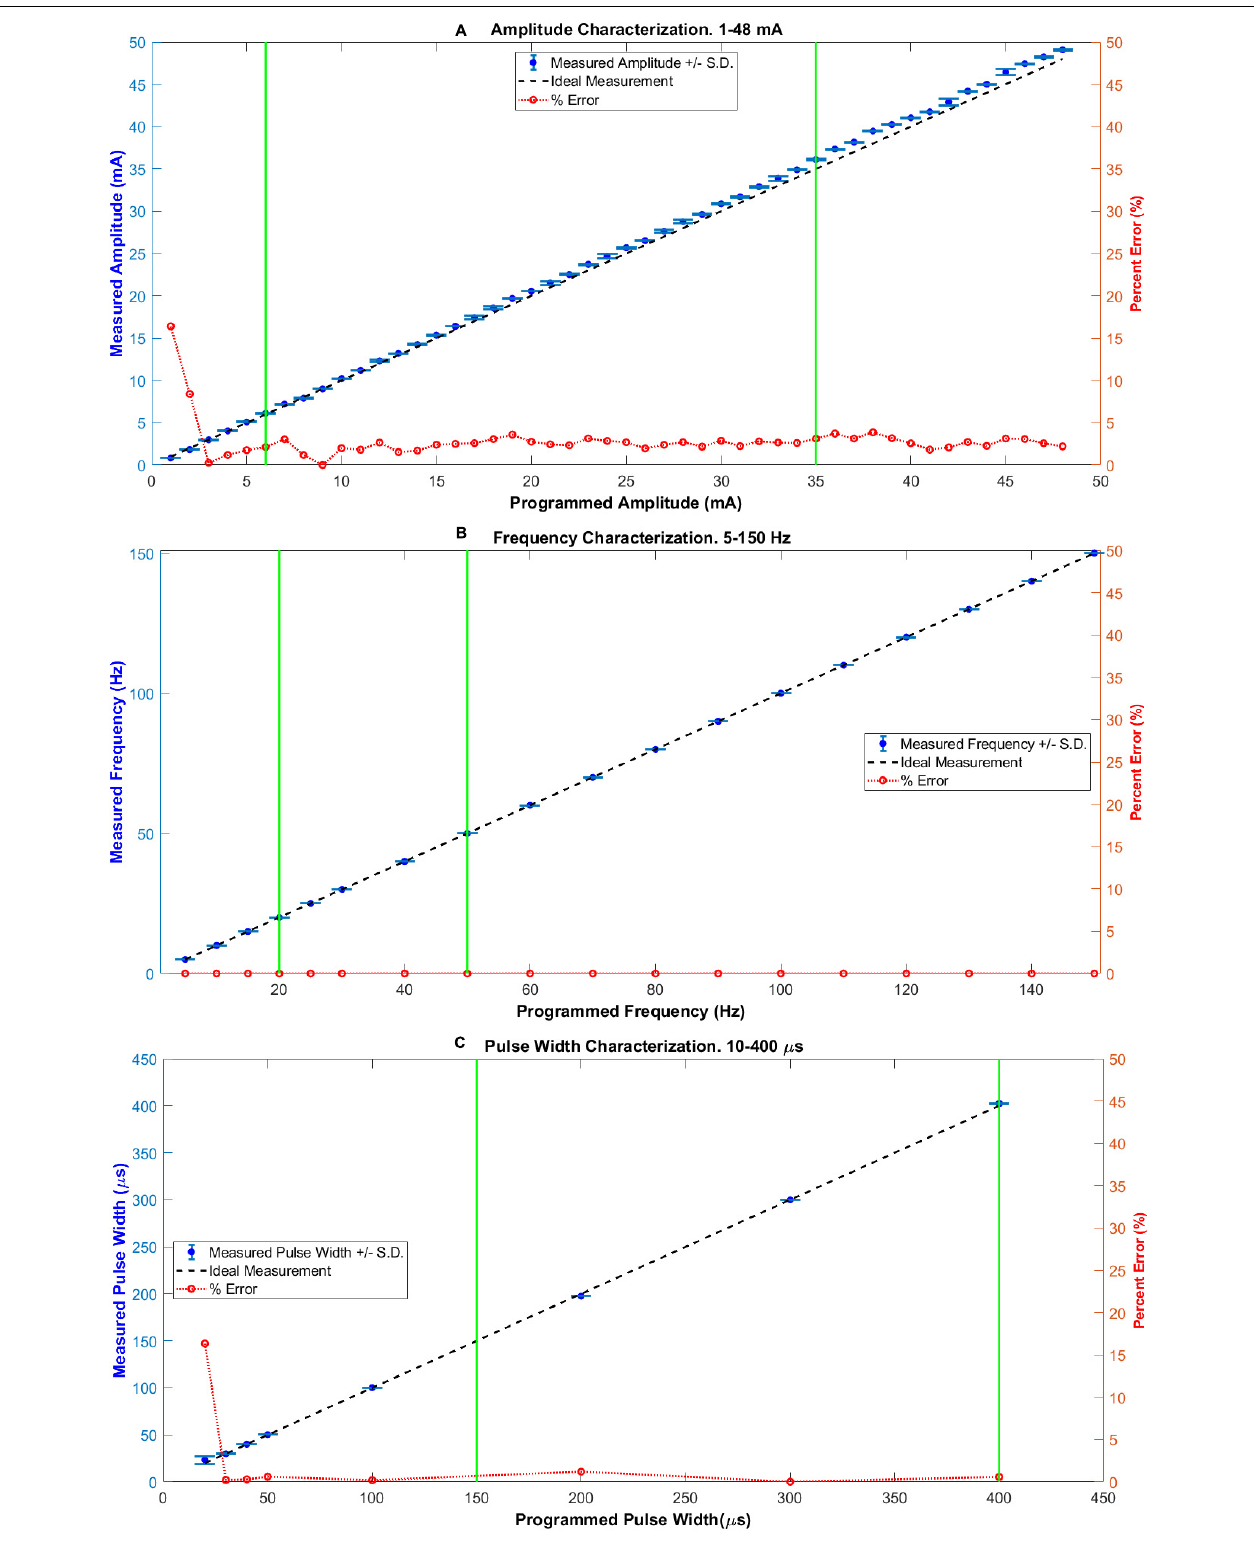
FIGURE 3 | Characterization of stimulation parameters: (A) amplitude, (B) frequency, and (C) pulse width. In each case, the values of parameters among the two vertical green lines define a range commonly used for upper limb FES applications. The maximum percentage error (%) inside these zones was 3.6, 0, and 1.21, for incises (A–C) ,